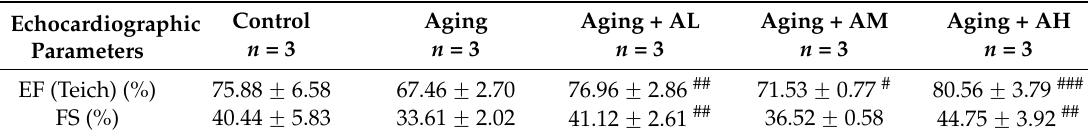
Table 1. Echocardiographic parameters in the studied